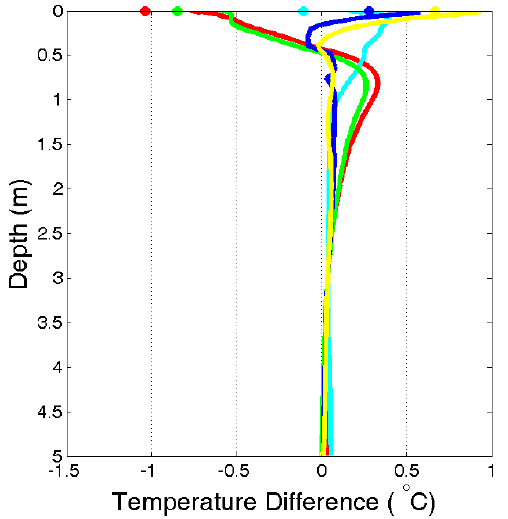
Fig. 4. GC99 data set: differences between the modelled and in situ Fig. 4 : GC99 dataset: differences between the modelled and in-situ measurements for the Base measurements for the Base (blue), Blend (yellow), EWB (green), (blue), Blend (yellow), EWB (green), EST (red) and BST (cyan) models. The surface points EST (red) and BST (cyan) models. The surface points are the dif- are the differences between modelled and M-AERI skin temperatures. ferences between modelled and M-AERI skin temperatures. Fig. 5 : Time-series temperature depth plots for GL03 case study: observational plot and temper- Fig. 5. Time-series temperature–depth plots for the GL03 case study: observational plot and temperature difference (modelled mi- ature difference (modeled minus observed) plots for the 5 model versions. Red curve represents nus observed) plots for the five model versions. Red curve repre- observed solar irradiance (Wm − 2 ). The white area used represents an ideal ∆ T T of ± 0.1 K. sents observed solar irradiance (Wm − 2 ). The white area used rep- resents an ideal 1T T of ±